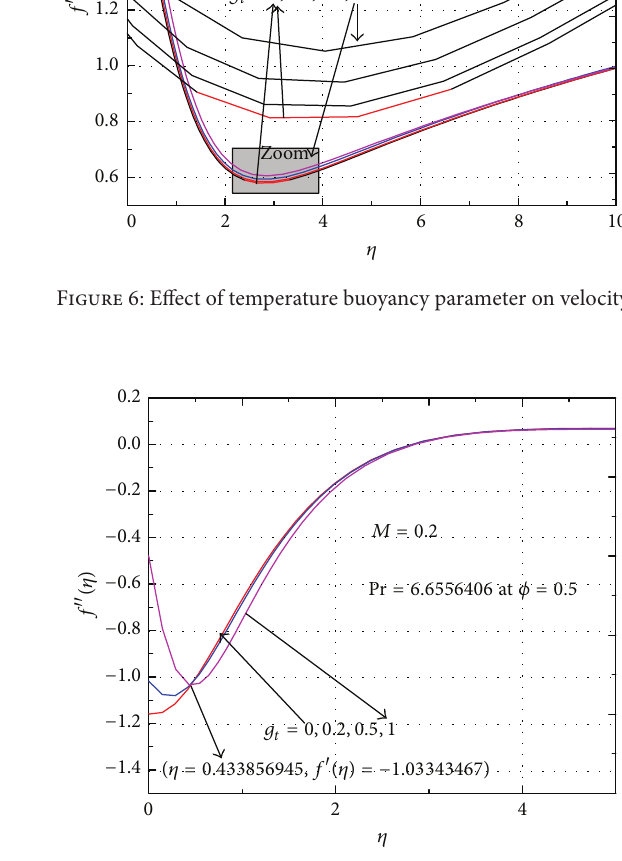
Figure 7: Effect of temperature buoyancy parameter on shear